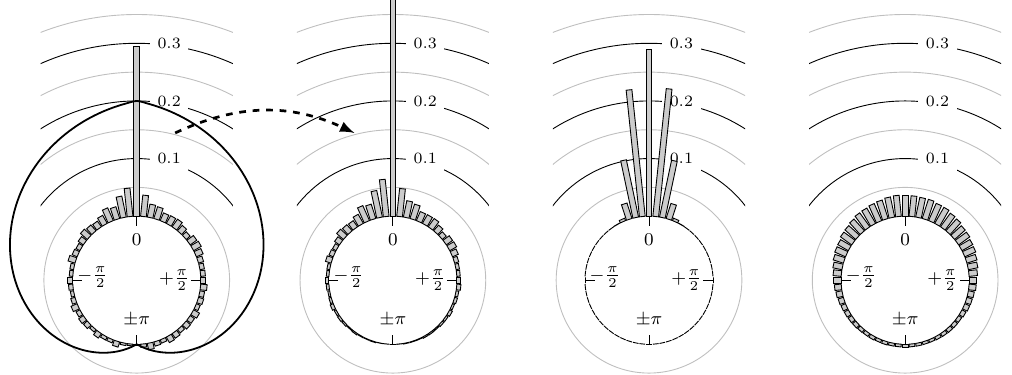
Figure 4. ( first ): example of a possible distribution of phase shifts and a hat function on S 1 ; ( second ): corresponding weighted version of the example distribution from first plot; ( third ): plot of the probability density functions of von Mises distributions mean location parameter µ = 0 and concentration parameters κ = 50; ( fourth ): same as third but with κ =